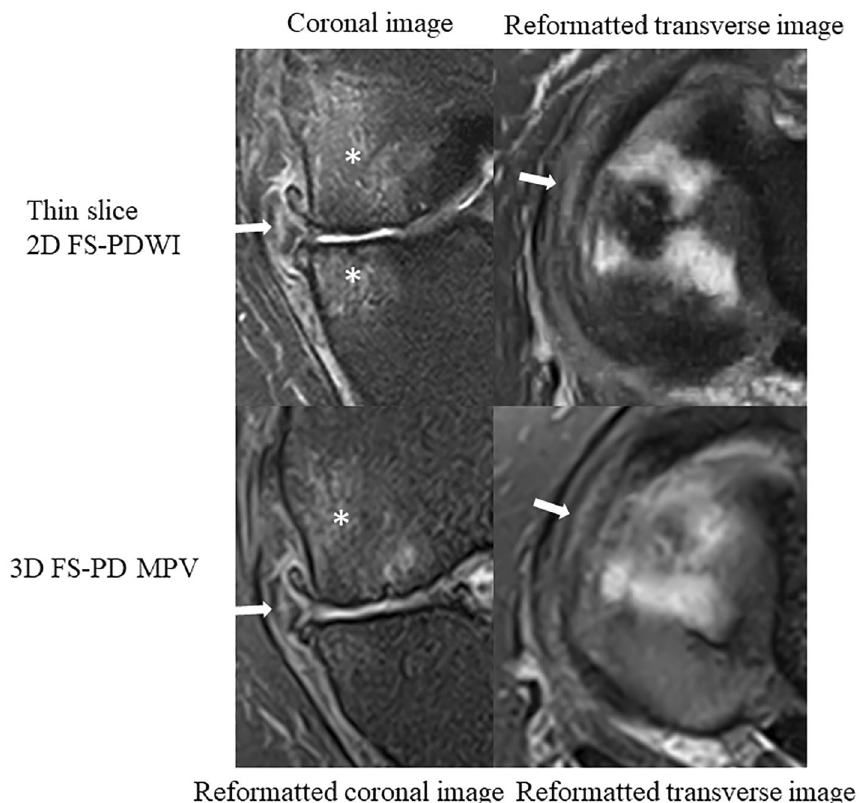
Figure 5. A 58-year-old woman with vertical tear of the medial meniscus (arrow) and bone marrow edema-like lesion of the medial condyle (asterisk). Vertical tear is well delineated in both thin-slice 2D FS-PDWI and 3D FS-PD MPV image, but high signal intensity of the tear is more distinct in thin-slice 2D FS-PDWI. For bone marrow edema-like lesion of the medial condyle, thin-slice 2D FS-PDWI provides better image depiction than 3D FS-PD MPV image. 2D FS-PDWI indicates 2-dimensional fat saturated-proton density weighted image; 3D FS-PD MPV, 3-dimensional fat saturated-proton density multi planar